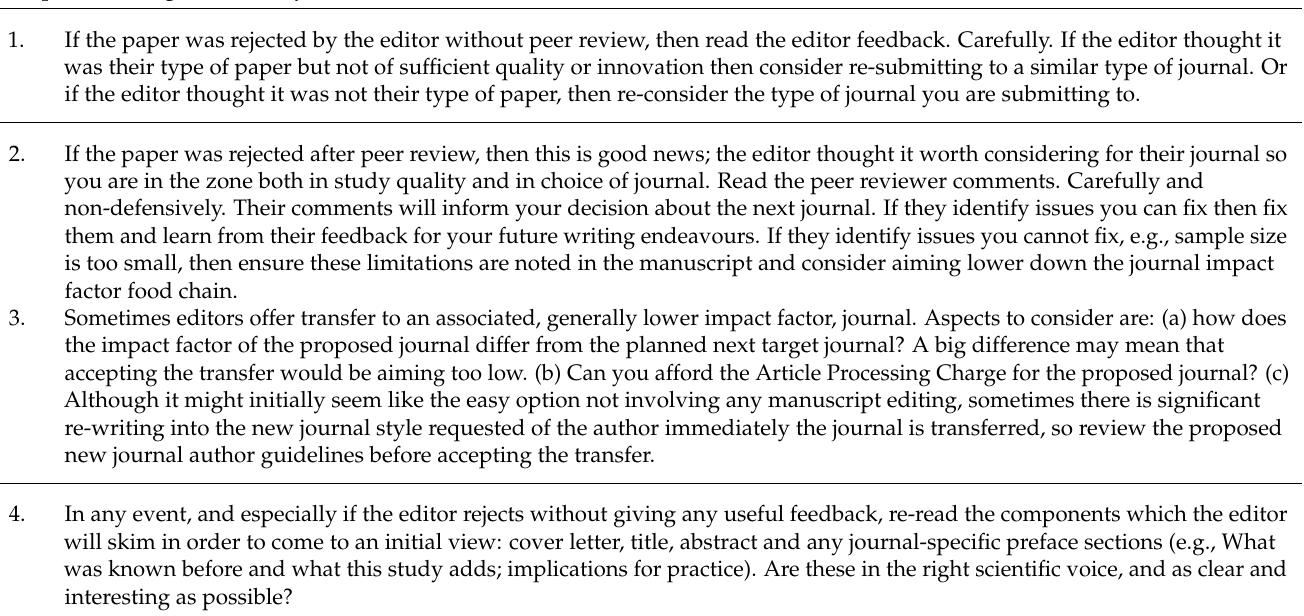
Table 4. Process of re-submission after